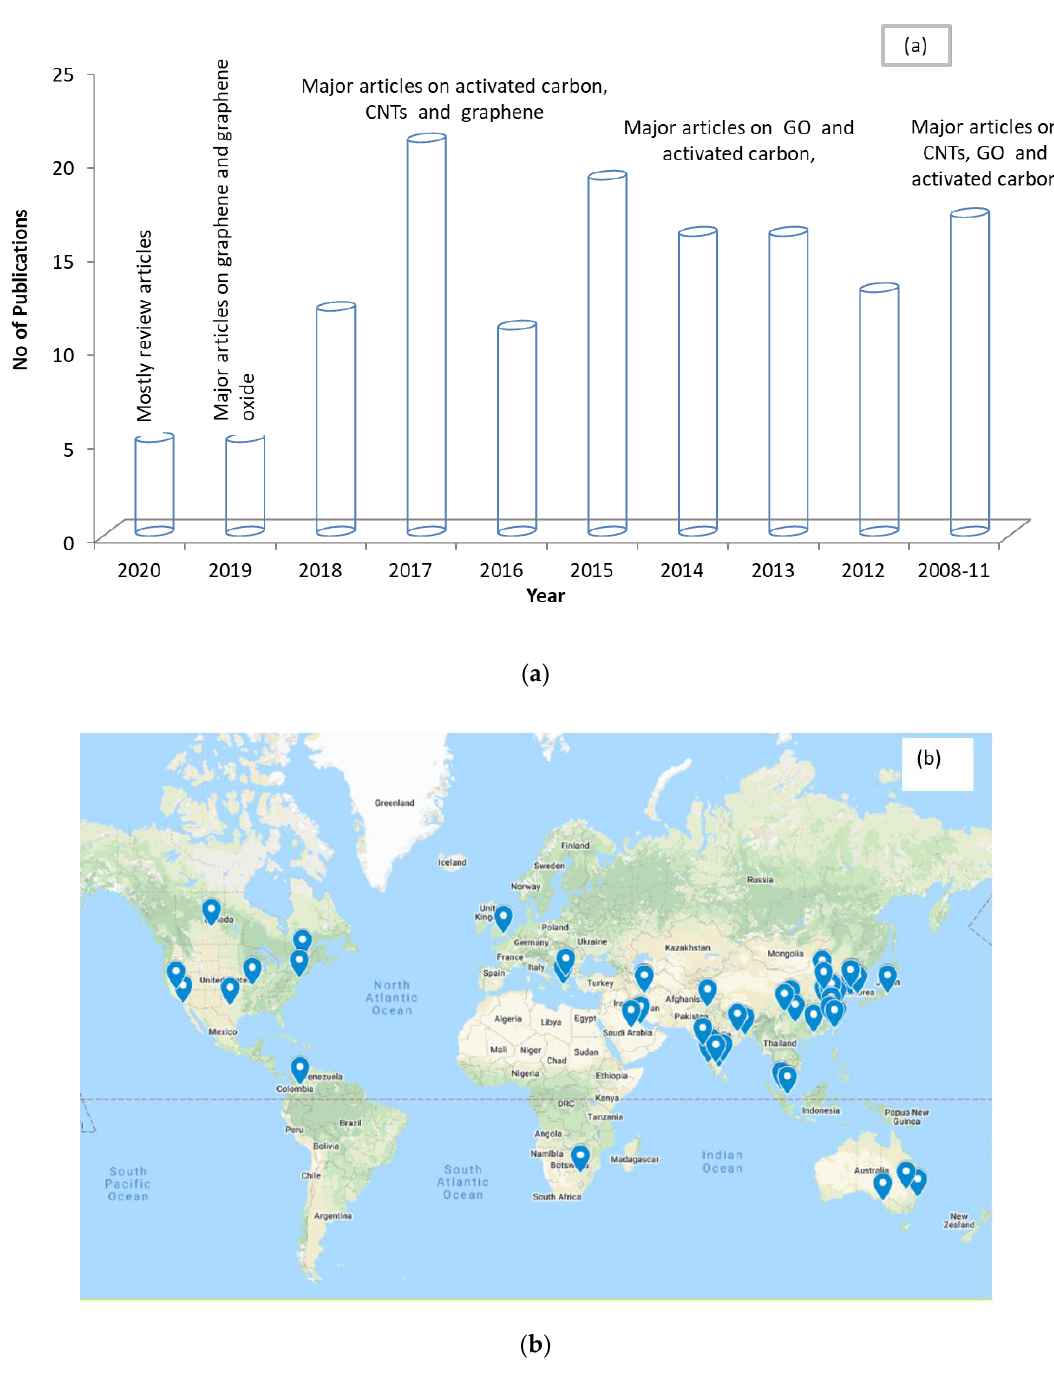
Figure 4. Representation of publications by year ( a ) and geographical location ( b ) from 2010–2020 for articles on water purification using carbon nanoparticles.